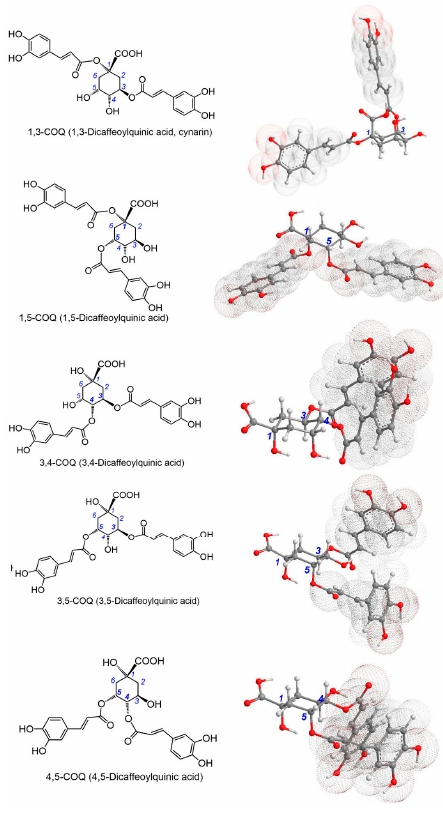
Figure 1. Structures ( left ) and preferential conformation-based ball-stick models ( right ) of five di- O-caffeoylquinic acids ( di-COQs ). The ball-stick models were created in Chem3D Pro 14.0. The screenshots from models are from the same perspective; i.e., C-1 was deposited on the right end, and –COOH is upward. The three-dimensional perspective animations are shown in Video S1–5. However, the relative degree of crowd for caffeoyl moieties remains unchanged.